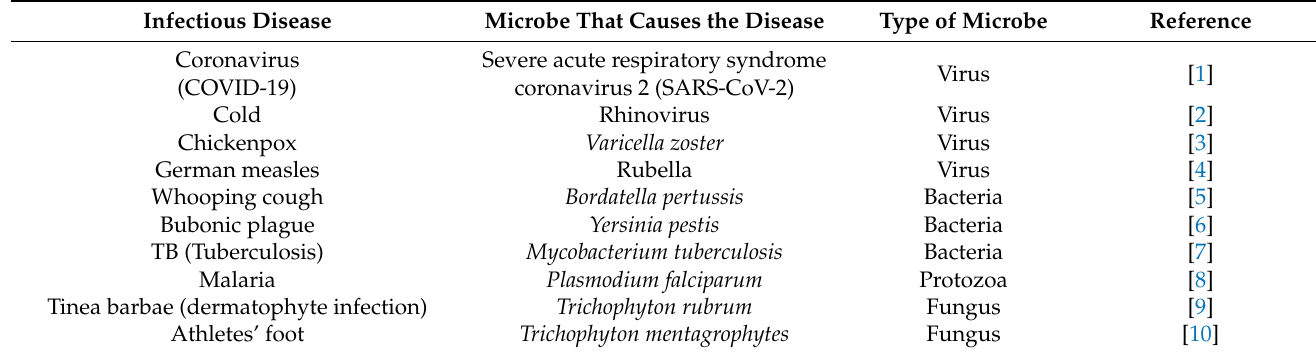
Table 1. Several infectious diseases caused by